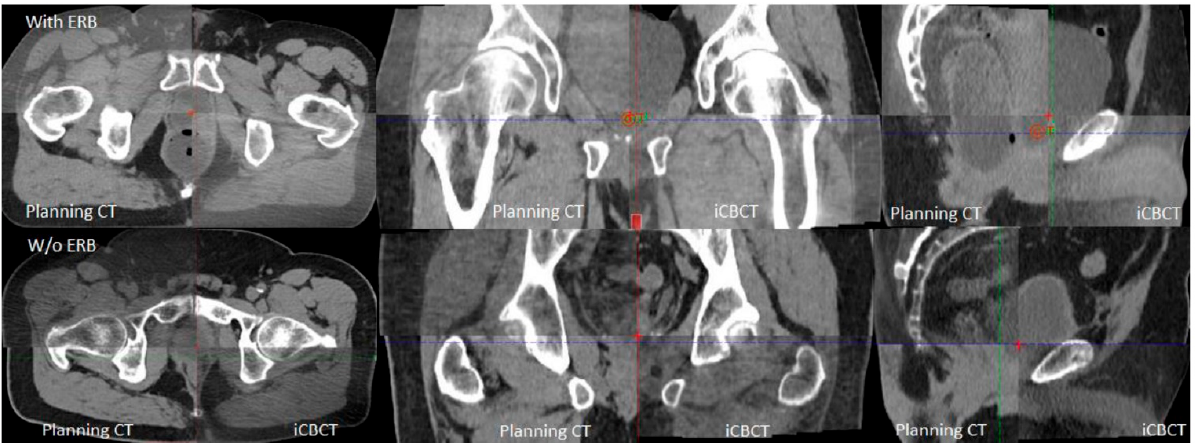
Figure 1. Axial, coronal, and sagittal views demonstrating planning CT and iCBCT image guidance to identify rectal wall and bladder interface and space between bladder and obturator musculature. Prostate bed CTVs, after being copied on daily iCBCT, were reviewed, translated, or rotated if needed, and approved by a radiation oncologist. The CTVs for two